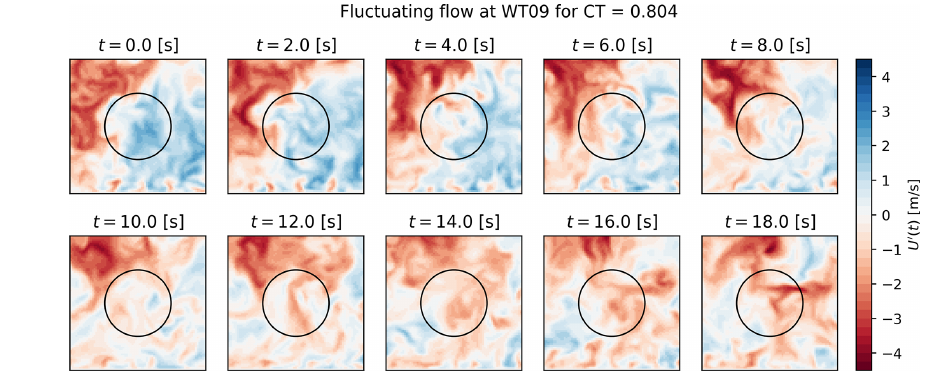
Figure 4. Instantaneous snapshots of the streamwise velocity fluctuations in a wake with C T = 0 . 806.